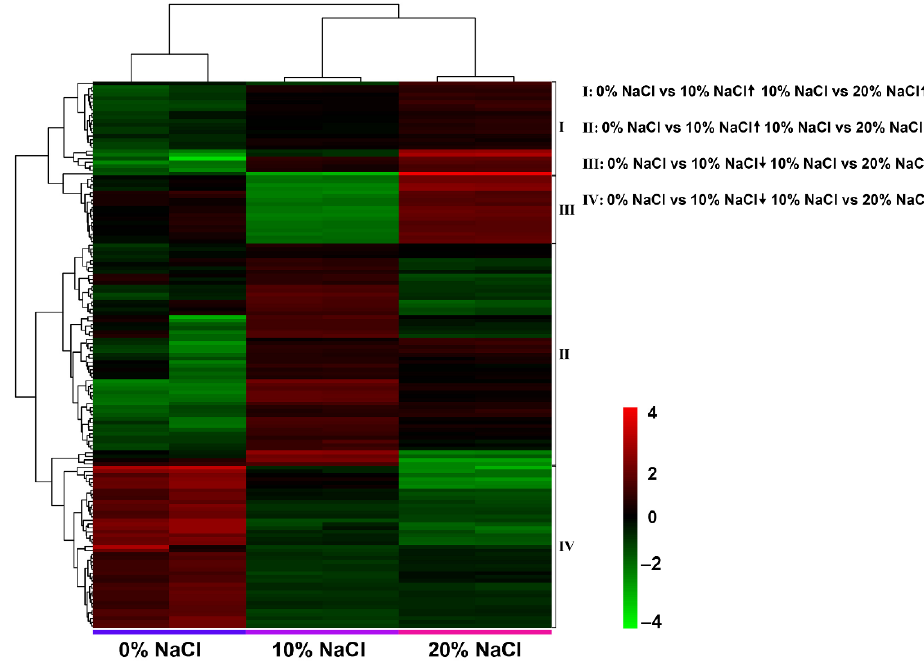
Figure 5. DEGs related to salt stress identified with pairwise comparison of four expression patterns. Heatmap of the four expression patterns of DEGs after a gradual increase in salt concentration.